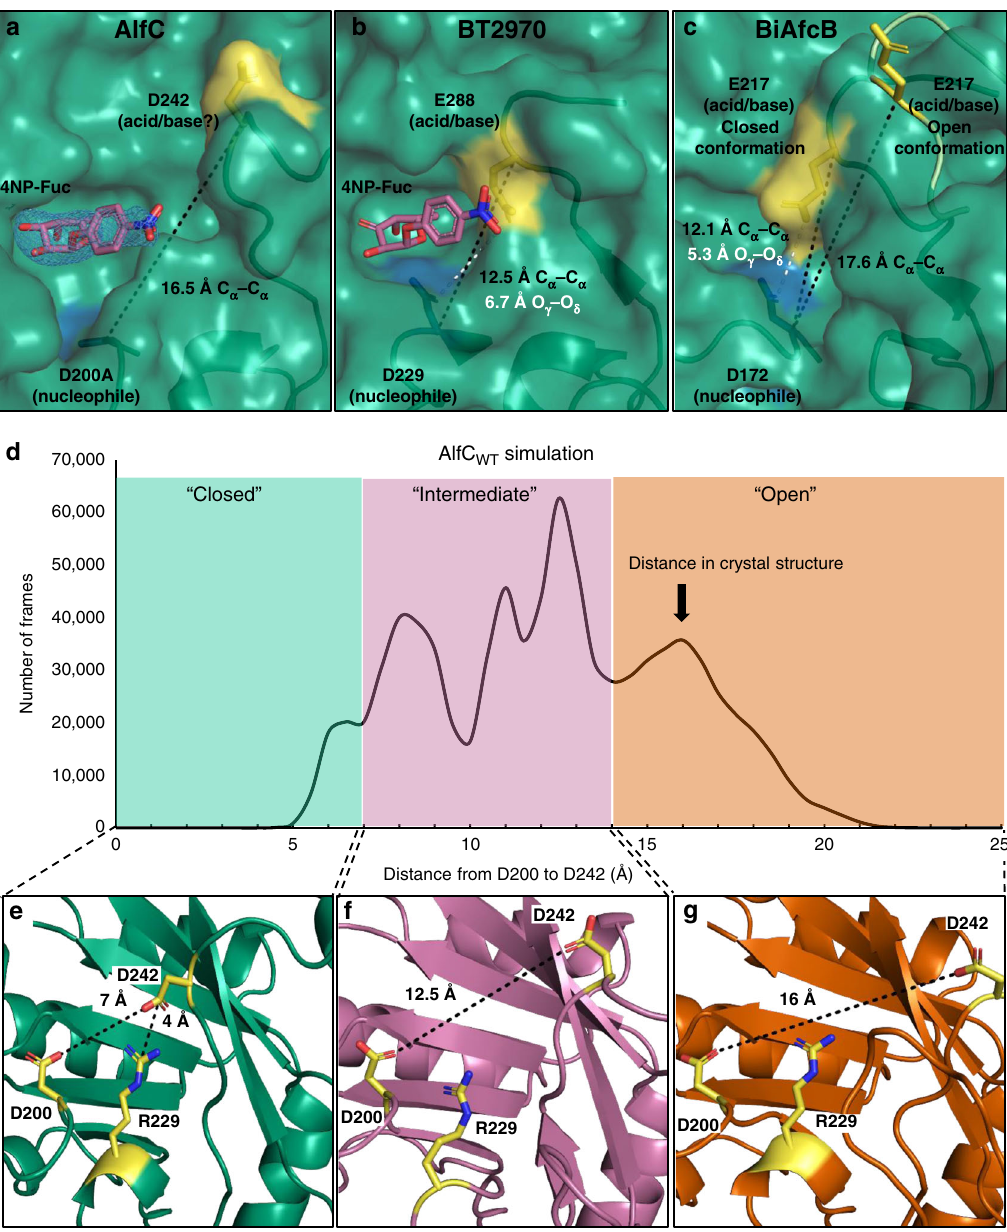
Fig. 3 Structure and dynamics of AlfC D242 loop. a Structure of AlfC D200A bound to 4-nitrophenyl- α - L -fucopyranoside (4NP-fuc) in an open conformation. The blue mesh represents a composite omit map of electron density surrounding 4NP-fuc, contoured to 1.5 σ , and carved to 1.7 Å. b Structure of BT2970 (PDB 2WVU) with the same substrate in a closed conformation. c Structure of BiAfcB exhibiting open (PDB 3MO4) and closed (PDB 3UES) conformations. d Molecular dynamic simulation of AlfC WT with frames plotted by the distance separating AlfC D200 and D242 O δ . e , f Representative frames depicting AlfC conformations. e Closed conformation depicting <7.5 Å distance between D200 and D242, with a salt bridge between R229 and D242; f intermediate conformation; g open conformation. Source data are provided as a Source Data fi